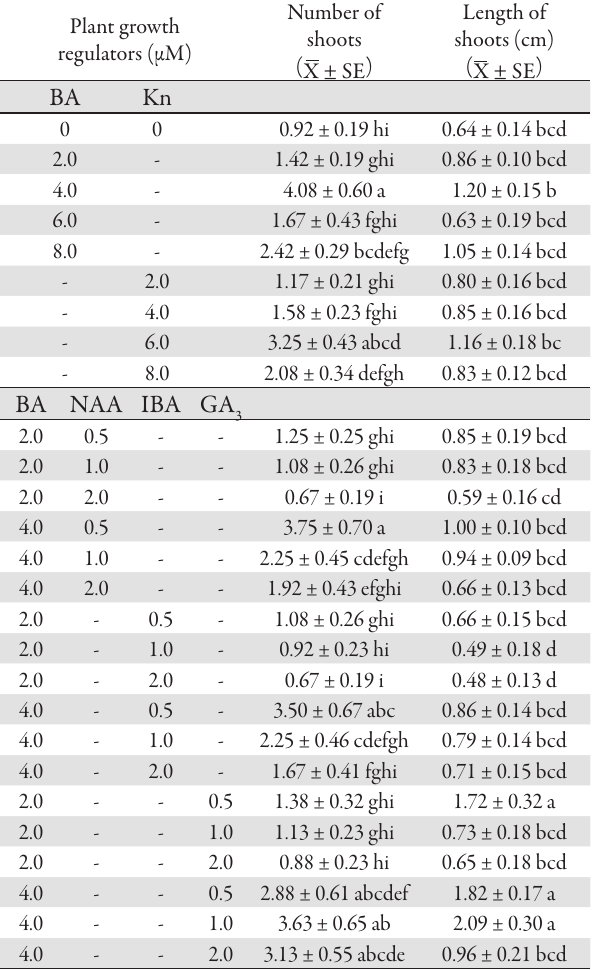
Tab. 3. Effects of plant growth regulators on axillary shoot proliferation from cotyledonary node explants of A. mangium